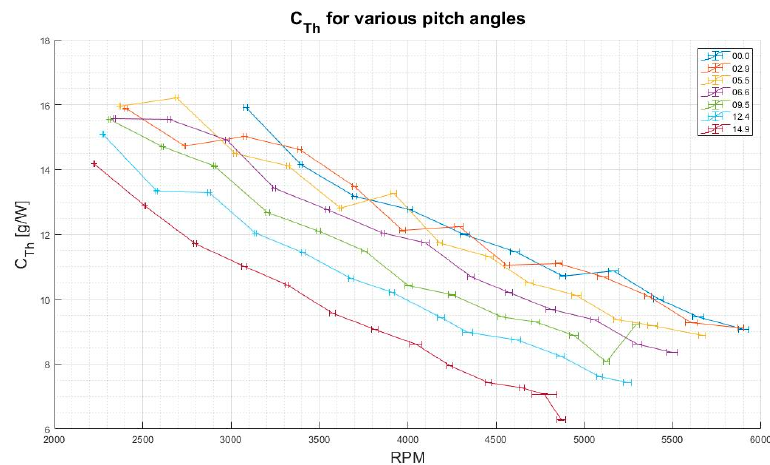
Figure 8. Coefficient of thrust during hover ( C Th ) for various pitch angles.